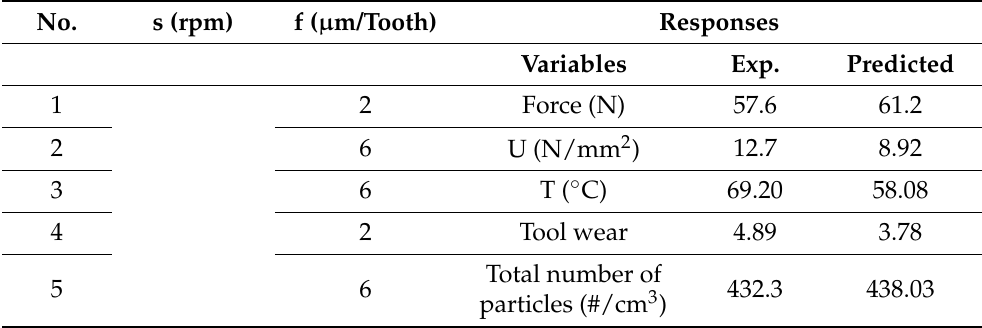
Table 7. Comparison between experimental data and predicted data for the recommended spin- dle